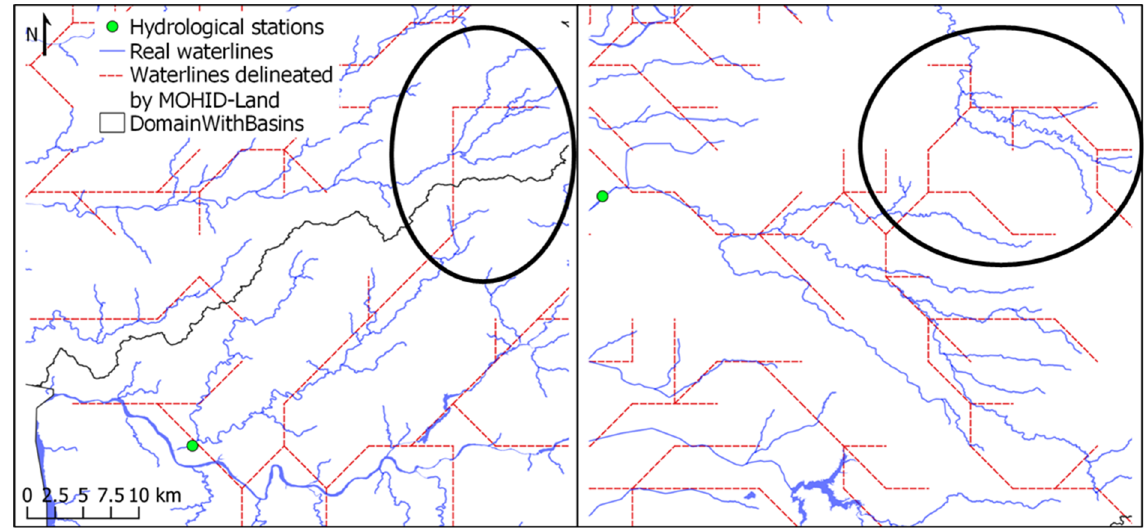
Figure 6. Details of the drainage network.